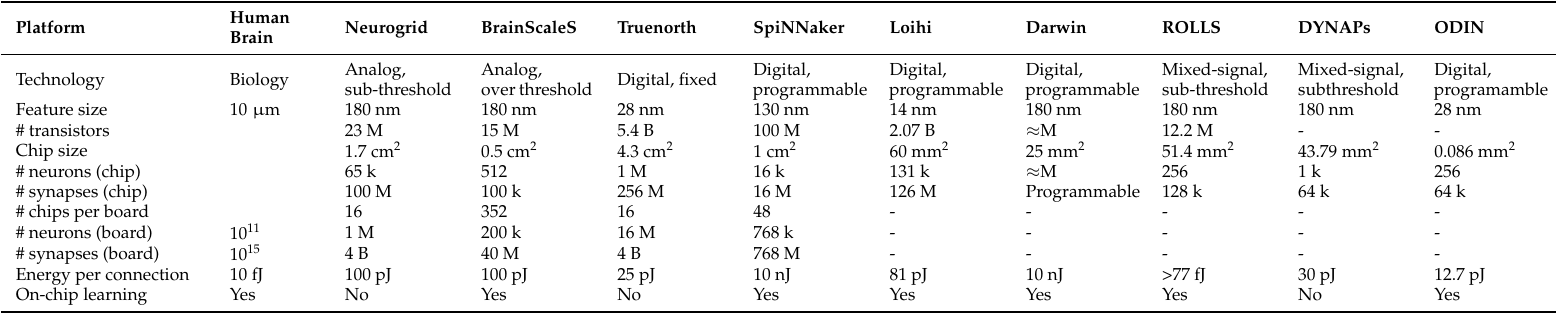
Table 2. Comparison of the major features of the human brain and the large-scale neuromorphic systems described in this work.